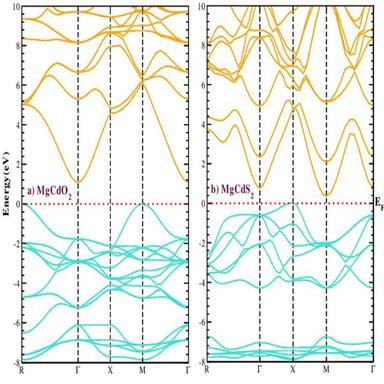
Calculated band structures for ternary MgCdX2 (X ¼ O, S) materials.